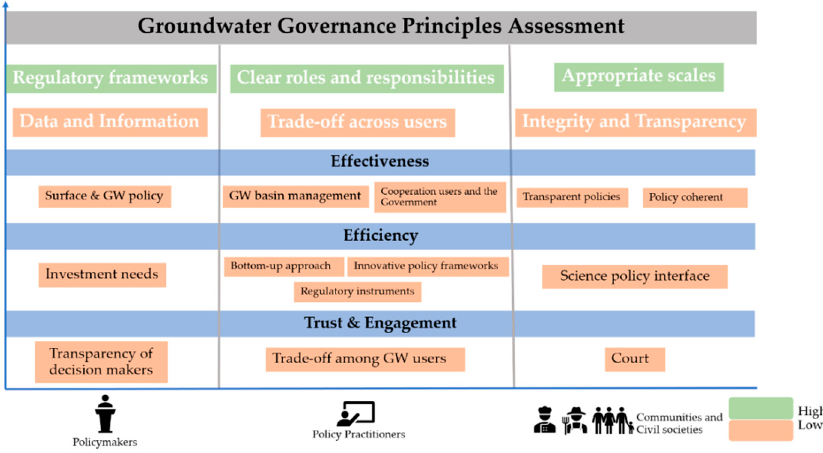
Figure 3. Key principles of the groundwater governance framework in different views.